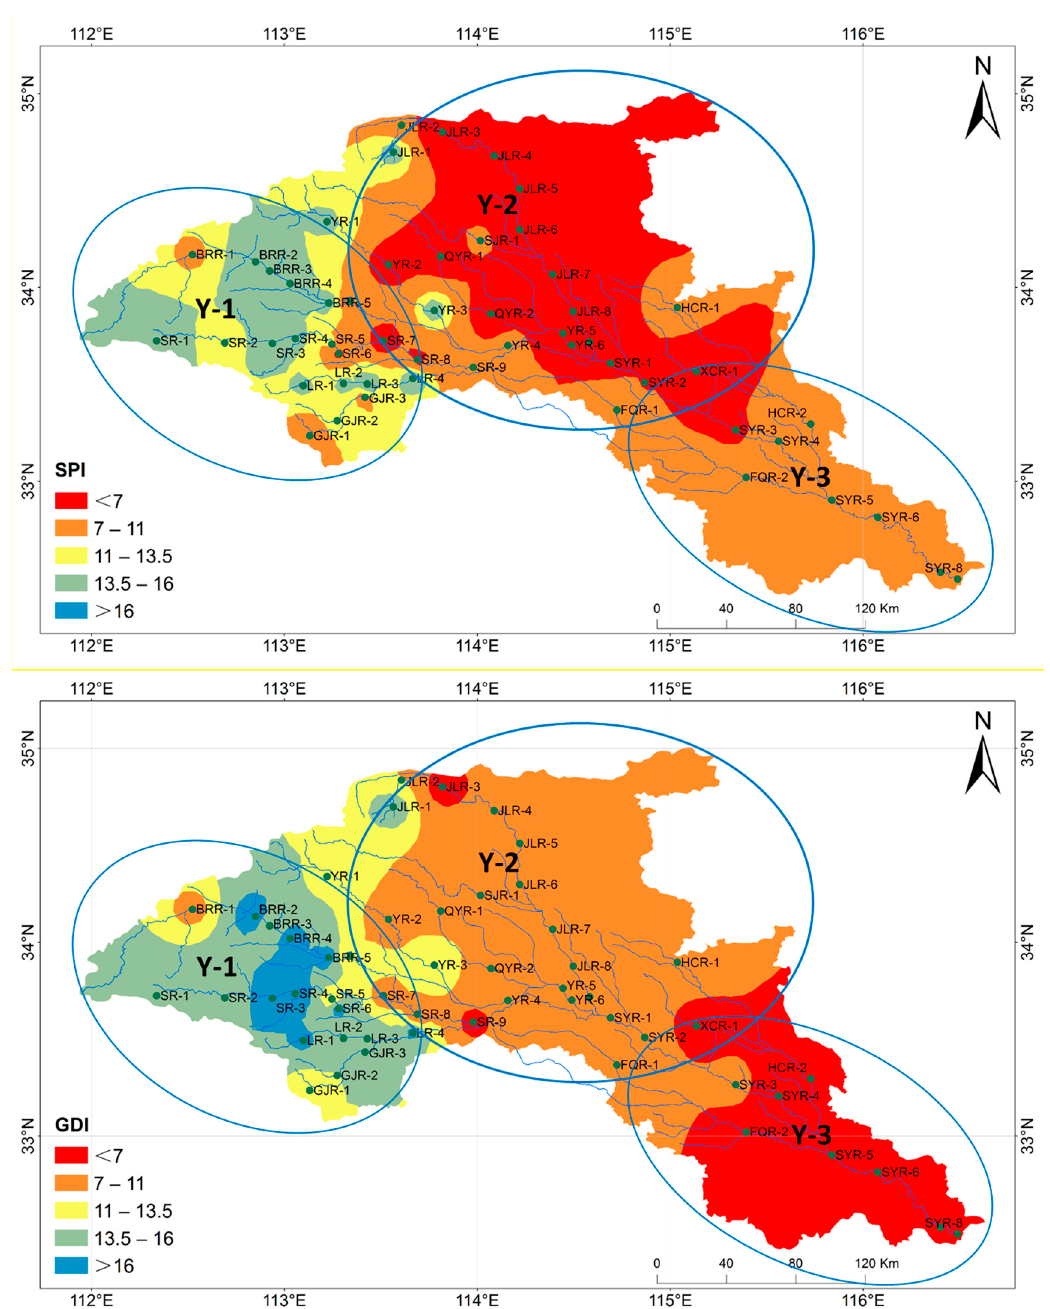
Figure 6. Values of diatom indices the Specific Polluosensitivity Index (SPI) and the Generic Diatom Index (GDI) in the Ying River.